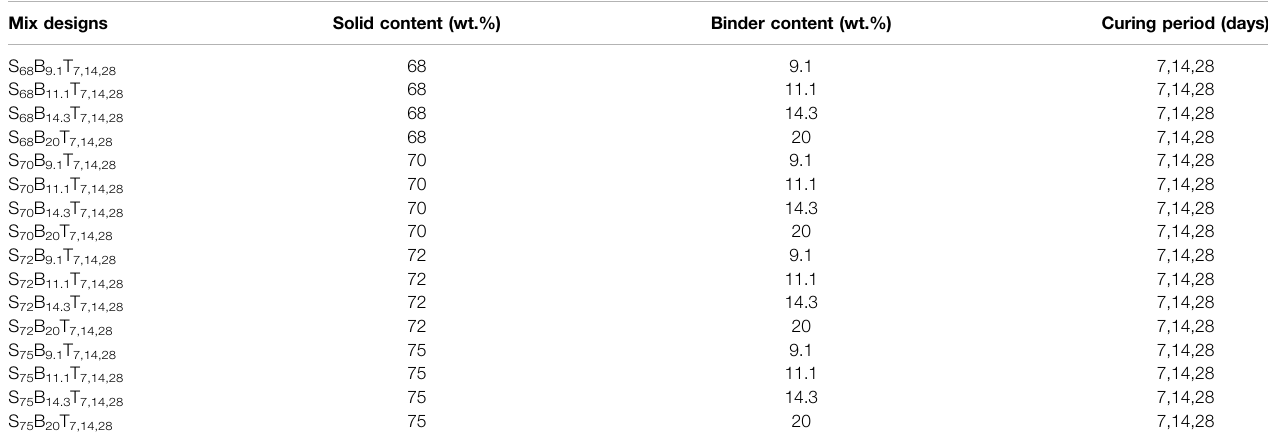
TABLE 2 | Mix designs and their